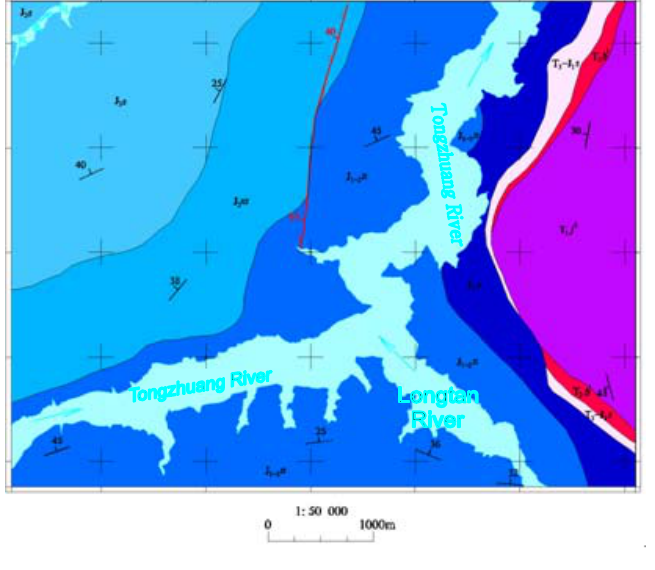
Figure 5. 1: 0.05 million geological map of